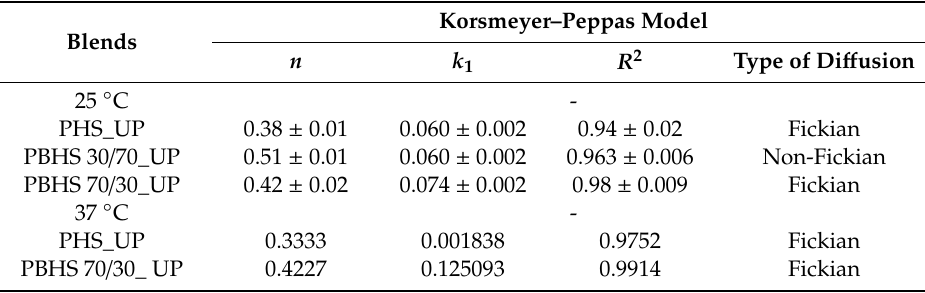
Figure 9. Simulation of initial release at 25 °C. ( a ) PHS_UP samples; ( b ) PBHS30/70_UP samples; ( c ) PBHS70/30_UP samples.